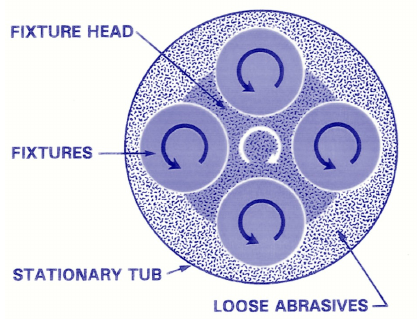
Figure 3. Drag finishing machine principle.